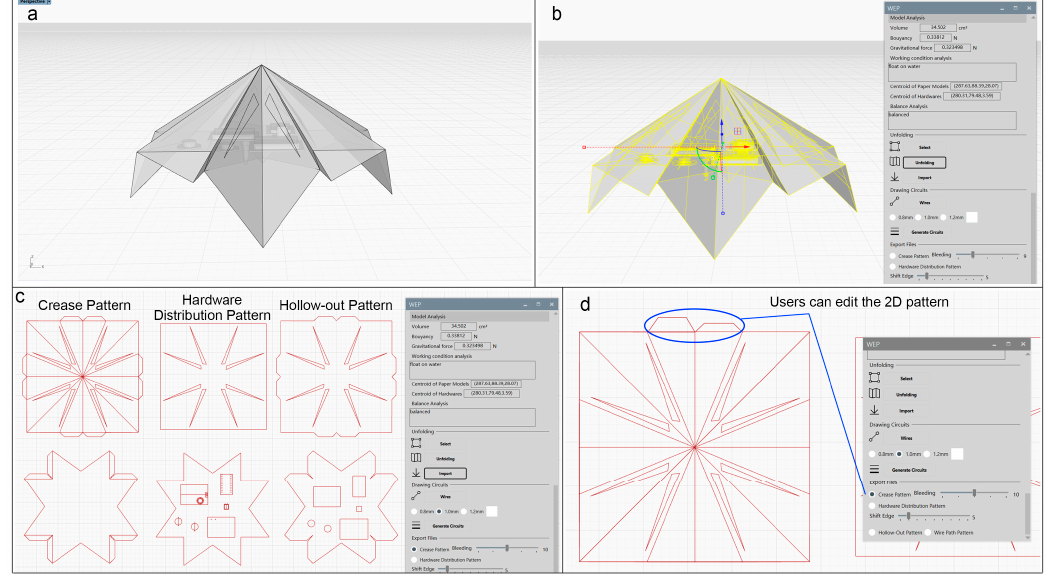
Figure 8. ( a ) Patching hollow surfaces; ( b ) select and unfold three ‐ dimensional (3D) model; ( c ) generate three kinds of patterns; and, ( d ) users can edit two ‐ dimensional (2D) patterns.